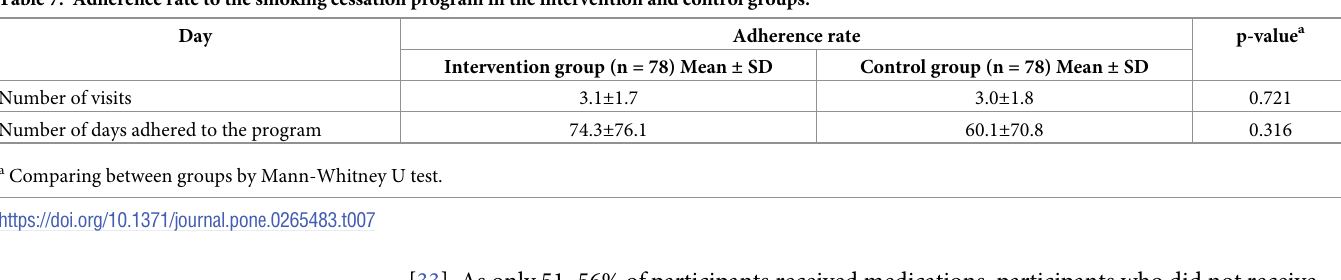
PLOS ONE | https://doi.org/10.1371/journal.pone.0265483 March 29,